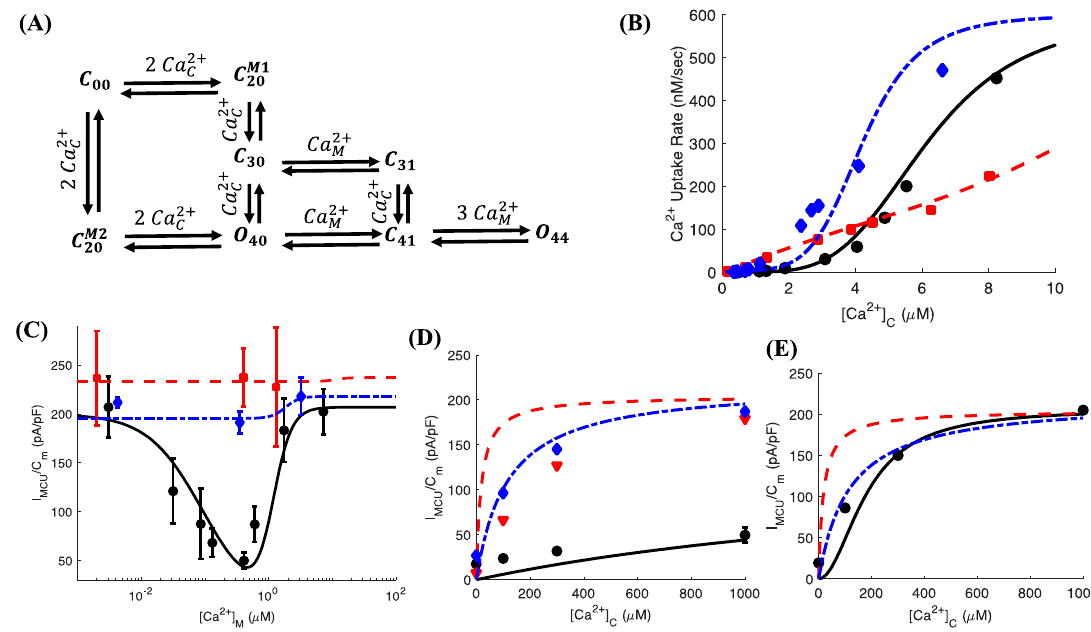
Figure 1. Scheme and fit to the experimental data of the MCU model. ( A ) The model consists of six close states ( C XY ) and two open ( O XY ) states. The subscripts X and Y represent the number of Ca 2 + bound to domains of MCU on the cytosolic and matrix sides of the IMM. The superscripts M1 or M2 on the two close states with 2 Ca 2 + bound on the cytosolic side indicate whether the ions are bound to the MICU1 EF hands or MICU2 EF hands. The channel has 2 Ca 2 + bound to MICU1 and one Ca 2 + bound to MICU2 on cytosolic side in state C 3Y . ( B ) Ca 2 + uptake rate as a function of [Ca 2 + ] C in WT (spheres, solid line), MICU1 KO (squares, dashed line), and MICU2 KO (diamonds, dashed-dotted line) cells. ( C ) MCU current density (I MCU / C m ) as a function of [Ca 2 + ] M at [Ca 2 + ] C = 1 mM, ( D ) as a function of [Ca 2 + ] C at [Ca 2 + ] M = 0.4 µ M, and ( E ) as a function of [Ca 2 + ] C at [Ca 2 + ] M = 0 µ M in WT, MICU1 KO, and MICU2 KO mitoplasts. The lines and symbols use the same convention as in panel ( B ). Triangles in panel ( D ) represent MICU1 KD mitoplasts. Symbols and lines in panels ( B – E ) represent observed and theoretical values, respectively. Experimental data shown for comparison is from [12] ( B ) and [19] ( C – E ).